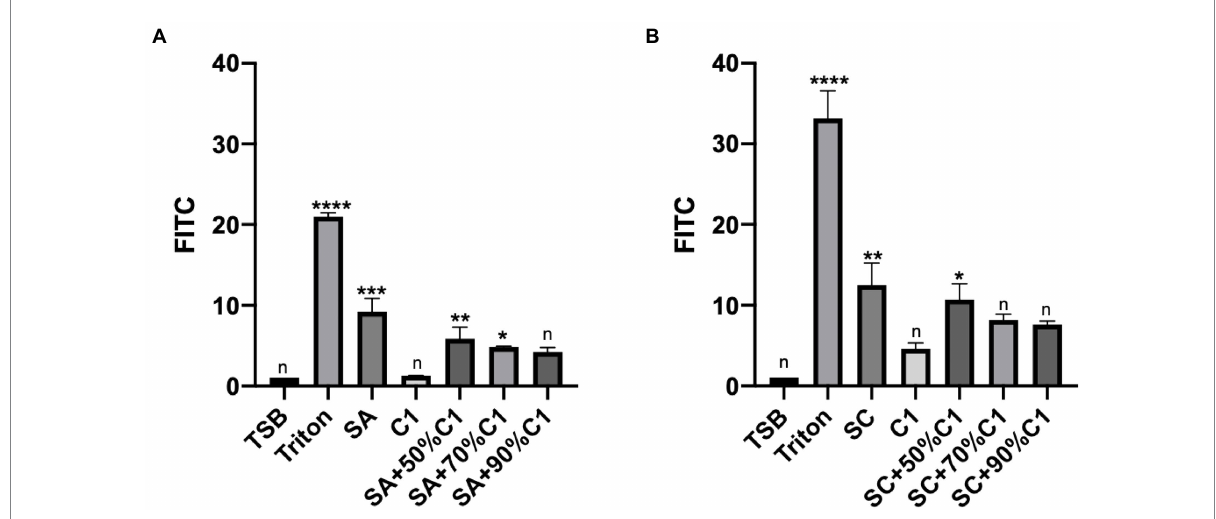
FIGURE 3 Corynebacterium accolens cell-free culture supernatants reduced with HNEC-ALI cultures paracellular permeability. The paracellular permeability. as measured by the FITC-Dextran Assay at 120 mins, following exposure to C. accolens cell-free culture supernatants, C. accolens cell-free culture supernatants from the mixed C. accolens - S aureus in different ratio and S. aureus ATCC strain [(SA) A ] or a clinical isolate of S. aureus [(SC) B ]. TSB served as the negative control and Triton treatment as the positive control. The significance was determined by comparing different treatment group with the negative control (TSB). Experiments were performed in triplicates. * p < 0.05, ** p < 0.01, *** p <0.001, **** p < 0.0001. n, no significance